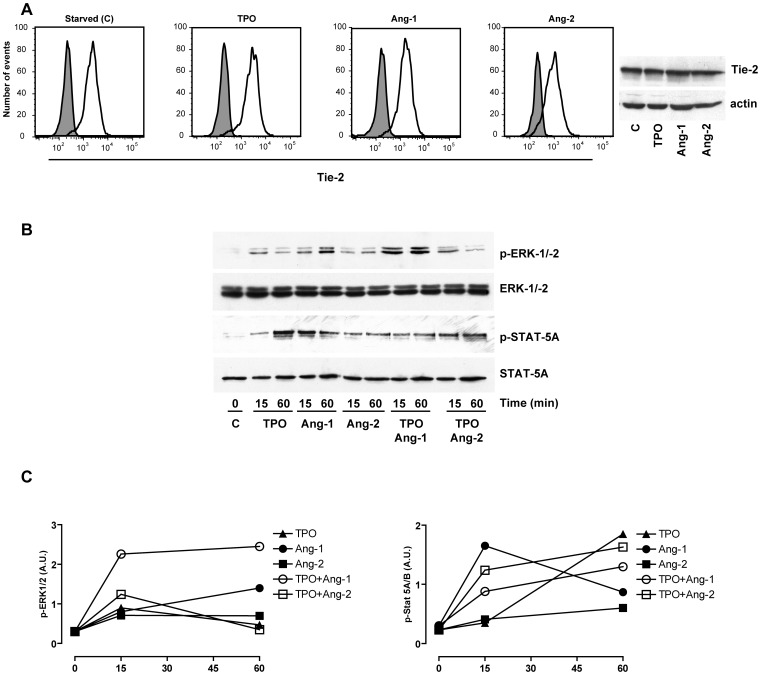
Angiopoietin and TPO-induced cell signaling in HUVEC cells.HUVEC cells, grown under standard endothelial cell culture conditions, have been starved overnight of growth factors and stimulated as indicated in panel B of Fig.10. A – Flow cytometry and Western Blot analysis of Tie-2 expression in HUVEC cells starved of growth factors and then stimulated for 15 min either in the absence (C ) or in the presence of either TPO or Ang-1 or Ang-2. B and C - WB and densitometric quantification (top and bottom panels, respectively).